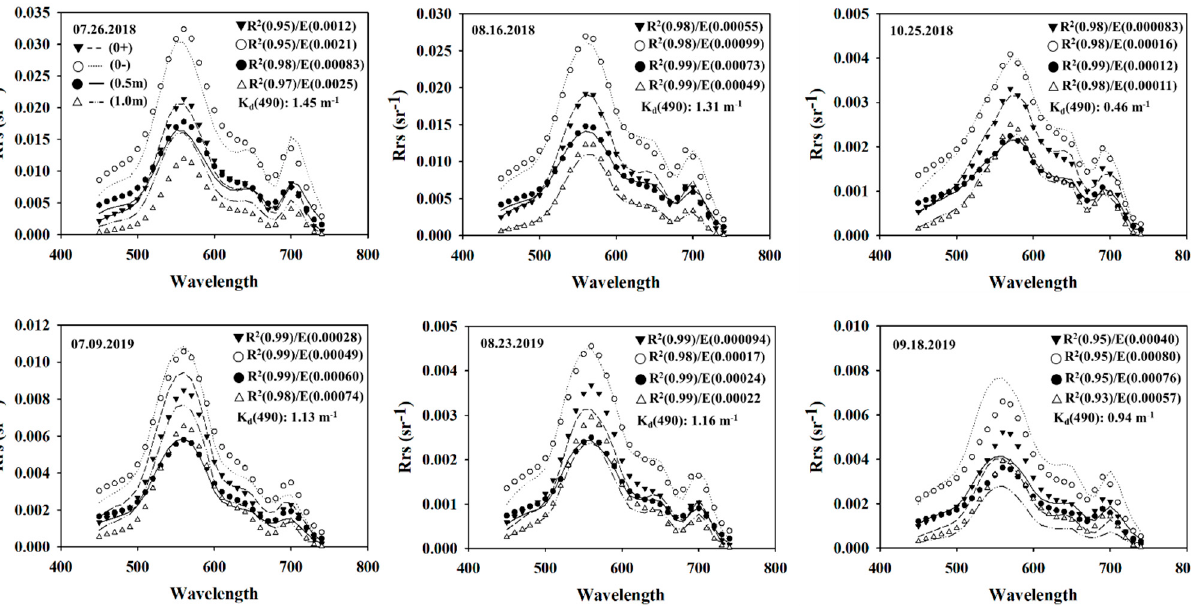
Figure 6. Remote sensing reflectance simulations using the calibrated parameters for the example sampling points. The dotted, dashed, solid, and double dotted lines represent the observed reflectance profiles with respect to the surface, beneath of surface, 0.5 m, and 1.0 m; black inverted triangles indicate the surface reflectance simulated using HydroLight; white circles represent the subsurface reflectance; black circles indicate the reflectance at 0.5 m of water depth; and white triangles represent the reflectance at 1.0 m. E indicates the root mean square error (sr − 1 ). K d (490) is the downwelling diffuse attenuation coefficient at 490 nm.Shen et al. [65] observed the effect of variation of the penetration depth from 0.09 m to 1.36 m in lake waters with high concentrations of chlorophyll ‐ a and suspended particulate matters. The simulated vertical profiles of reflectance showed good agreement with the observed profiles. The simulated spectra at various depths (i.e., surface, subsurface, 0.5 m, and 1.0 m) had R 2 values > 0.93 and RMSE values < 0.0025 sr − 1 . Lee at al. [66] showed that subsurface reflectance simulated using the HydroLight model had an error of 0.9%. In Nouchi et al. [67], the reflectance spectra were estimated at a depth of 1.0 m and measured within an acceptable level of uncertainty. However, the simulated spectra in the spectral range of 615 nm to 630 nm showed disagreements with the observed spectra, but the discrepancy was still within the range of the expected observation uncertainty (Figure 6). This may be because of the difficulty of accurately reflecting the characteristics of a cyanobacteria ‐ dominant bloom due to the presence of phycocyanin, which leads to a spectral curvature at 620 nm [6]. Overall, the calibrated parameters of the HydroLight model provided reason ‐ able simulation accuracy for the water reflectance of inland water with respect to the depth.